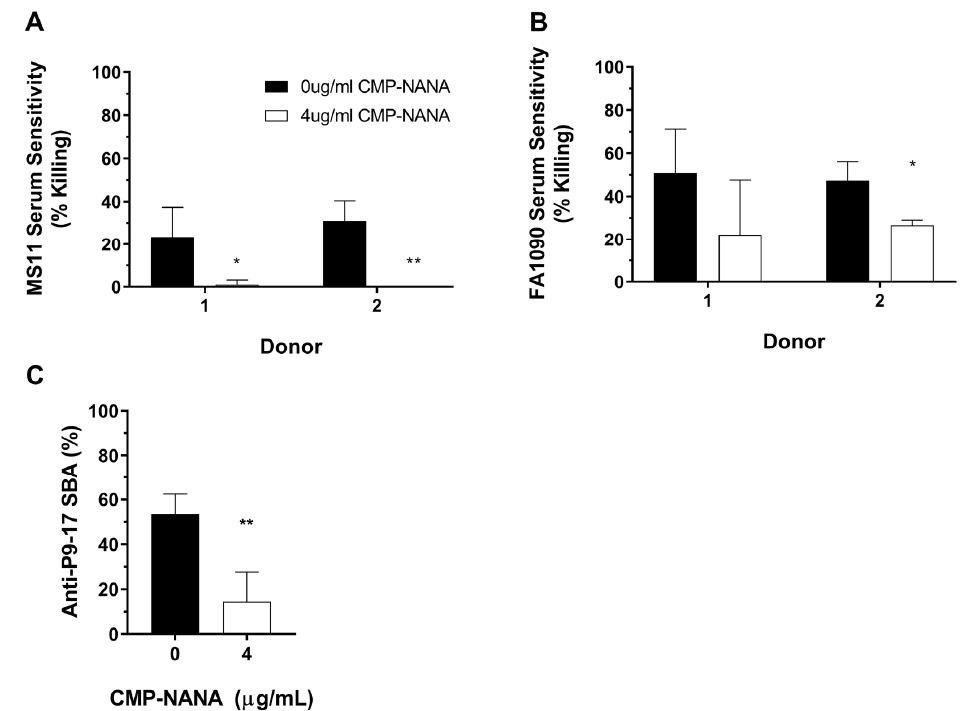
Figure 6. Reduction of serum or SBA sensitivity or after sialylation with cytidine-5 ′ -monophospho-N-acetylneuraminic acid (CMP-NANA). Mid-log broth subcultures of N. gonorrhoeae MS11 ( A ) or FA1090 ( B ) were incubated with/without the addition of 4 µg/mL CMP-NANA and samples taken to detect bacterial ATP. The P9-17 strain ( C ) was incubated under the same conditions with the addition of murine anti-P9-17 OMV anti-sera at a dilution of 1/64 to examine the effect of sialylation on SBA. Data are combined means + SD from three independent experiments; statistically significant differences in sensitivity were determined using multiple t -tests with the Holm–Šidák method applied ( A,B ) or a paired t -test ( C ). Values were reported as zero in experiments where bacteria numbers had increased in the presence of NHS. * p < 0.05; ** p < 0.01.